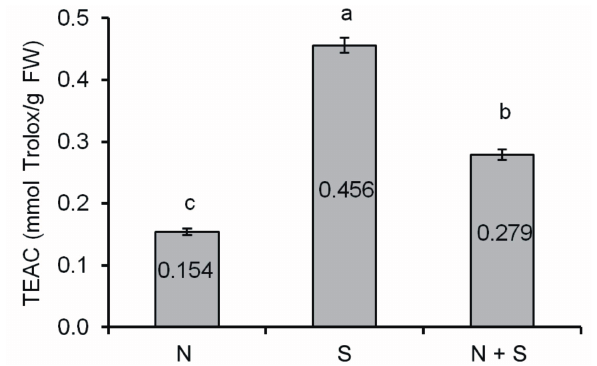
Figure 2. Trolox Equivalent Antioxidant Capacity (TEAC) of grape seeds (mmol Trolox/g FW). Means with the same letter (a,b,c) are not significantly different ( p < 0.05).